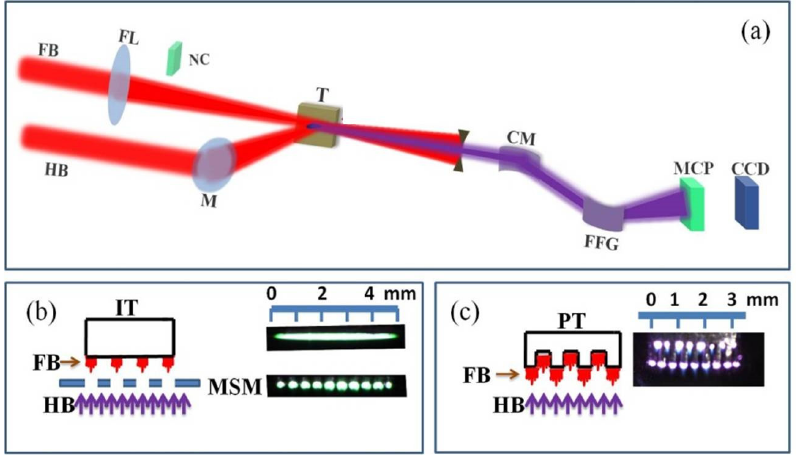
Figure 14. ( a ) HHG scheme. ( b ) Multi-jet plasma using multi-slit mask and flat surface. ( c ) Multi-jet plasma formed on the perforated target. Reprinted with permission from Ref. [49], 2019, American Institute of Physics.